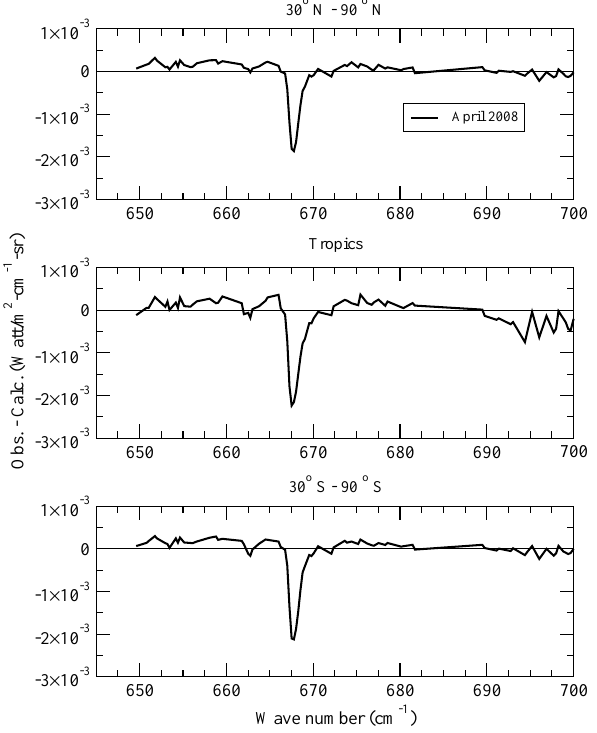
Fig. 3. AIRS spectral residuals averaged over a period of two weeks during April 2008. The input state vectors are ECMWF short-range forecast fields. The residuals have been computed using the RTTOV model. Results are shown for (a) Northern Hemisphere, (b) Tropics, and, (c) Southern